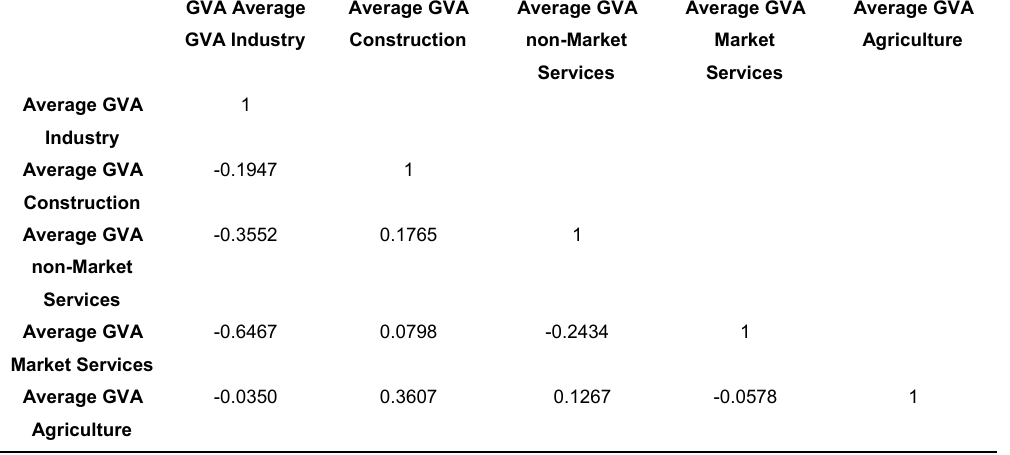
Table 11. Pairwise correlations between the sectorial components of the total Gross Value